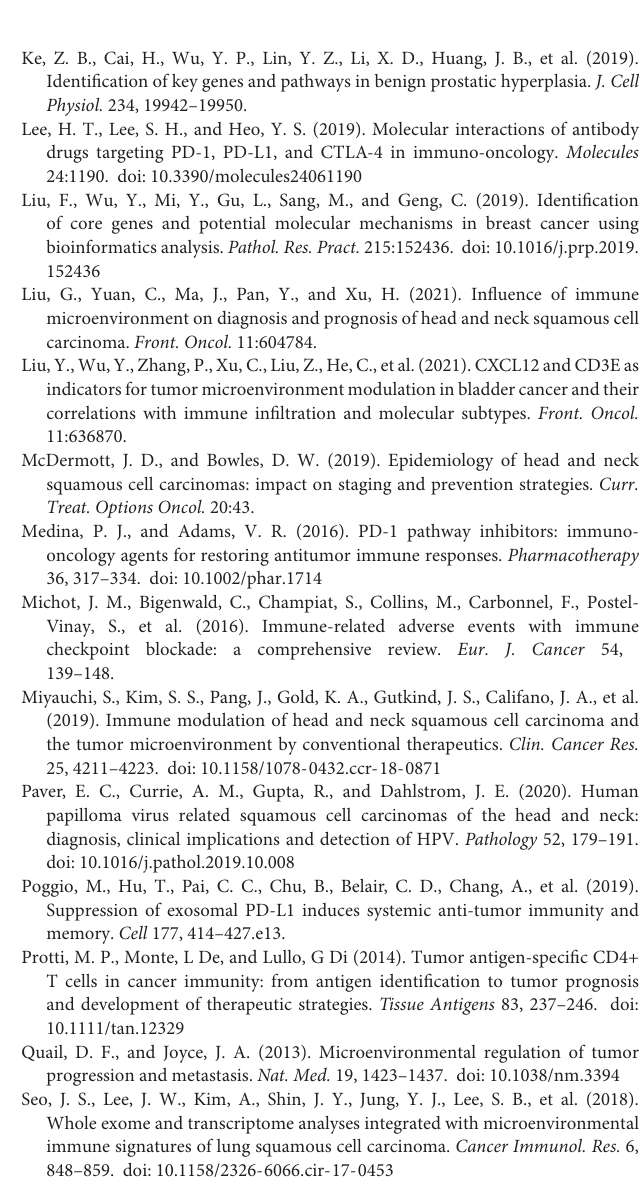
Supplementary Table 6 | Optimal number of clusters by unsupervised clustering